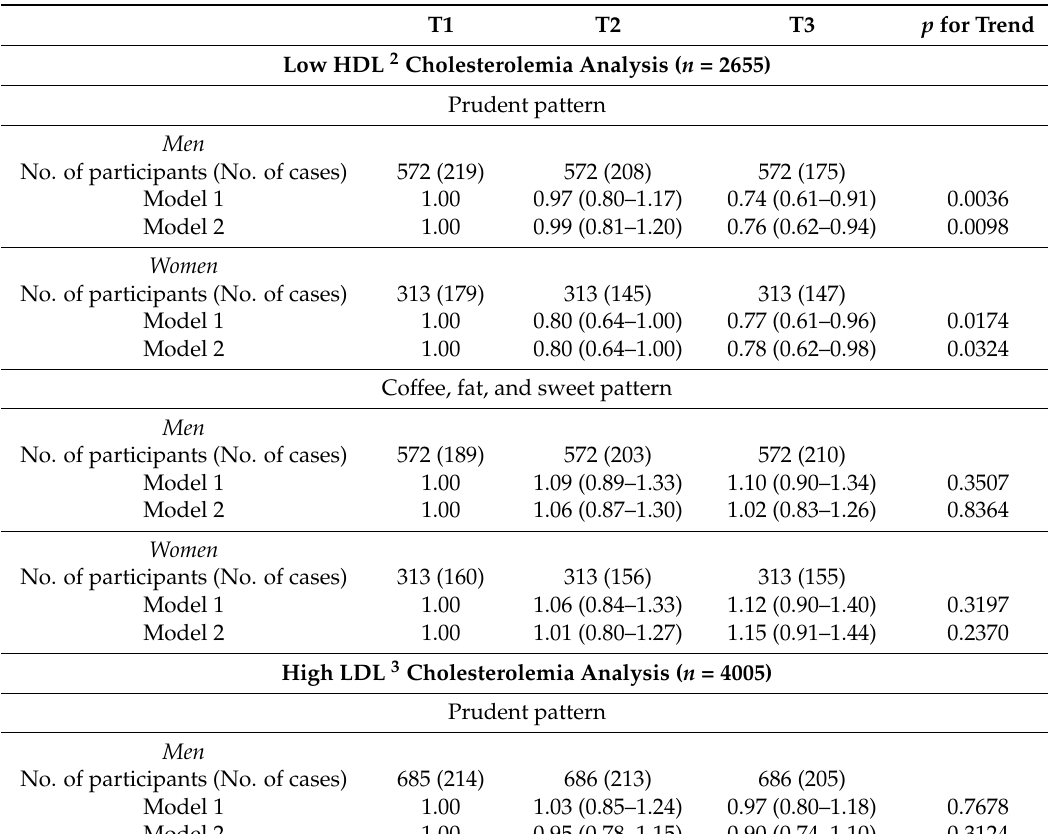
Table 6. Hazard ratios (HRs) and 95% confidence intervals (CIs) for the risk of incident cholesterolemia according to dietary pattern 1